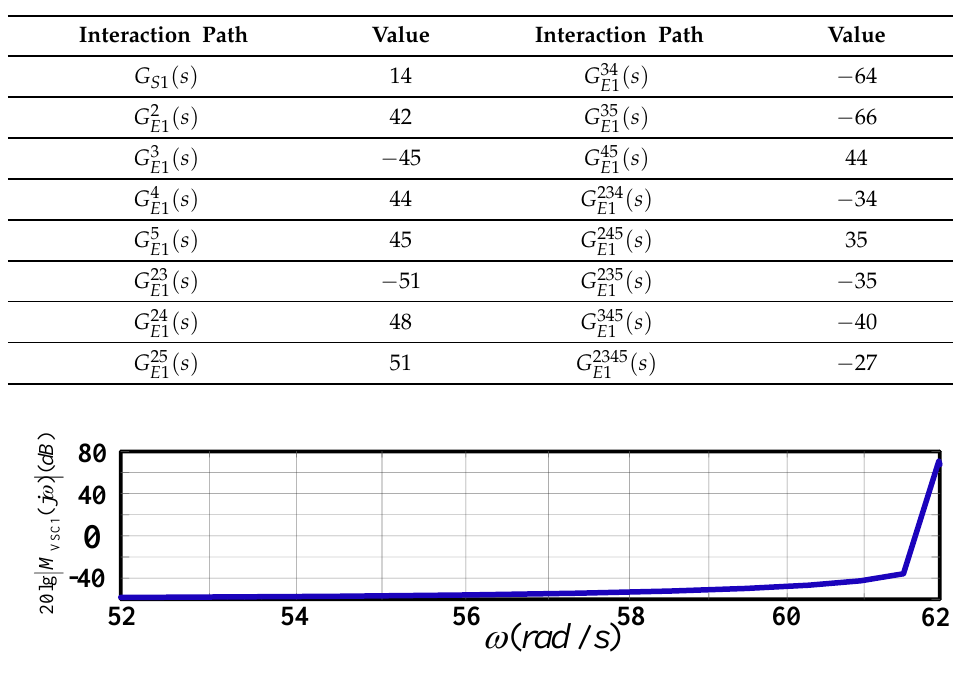
Table 2. Frequency characteristics of the real part through different paths.